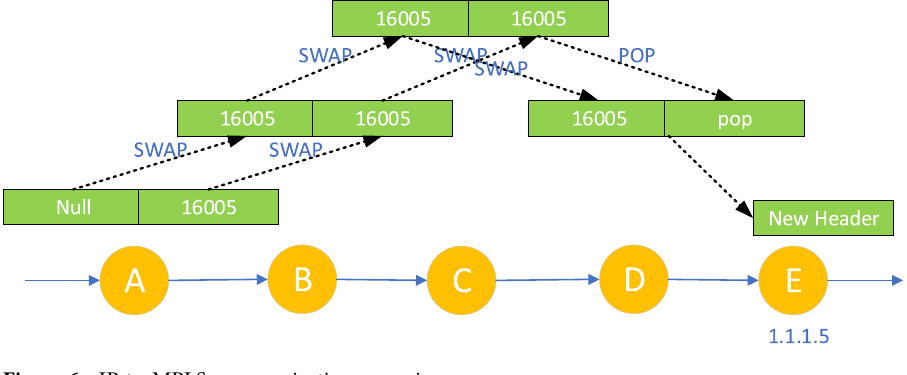
Figure 6. IP-to-MPLS communication